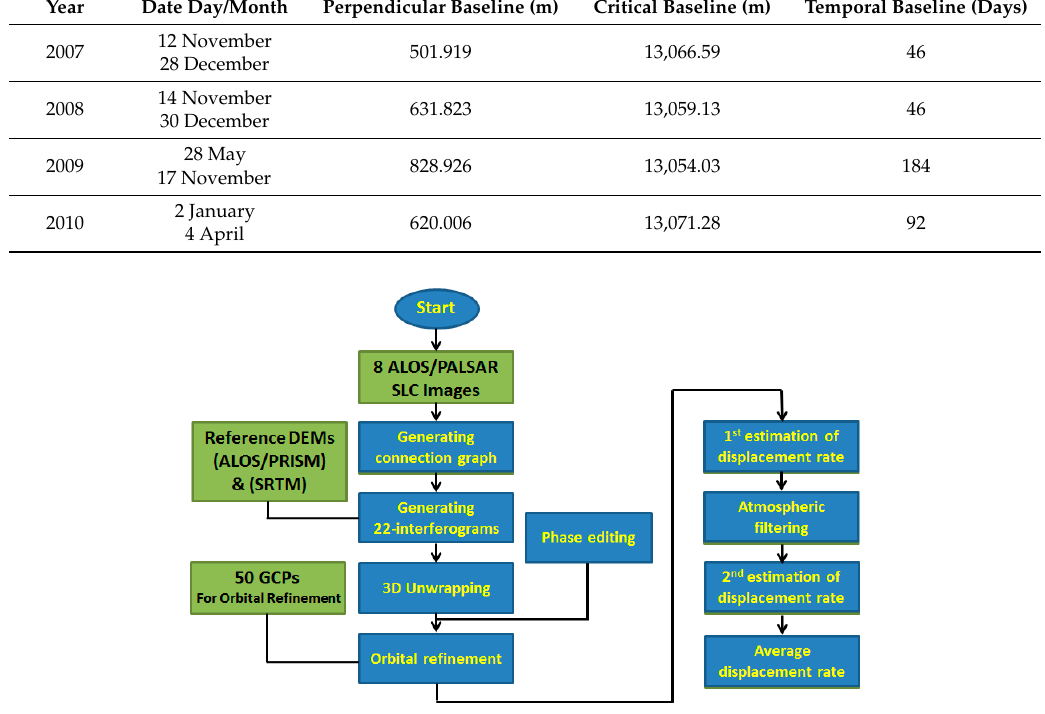
Figure 5. Applied processing workflow in this study using the DInSAR/SBAS module.